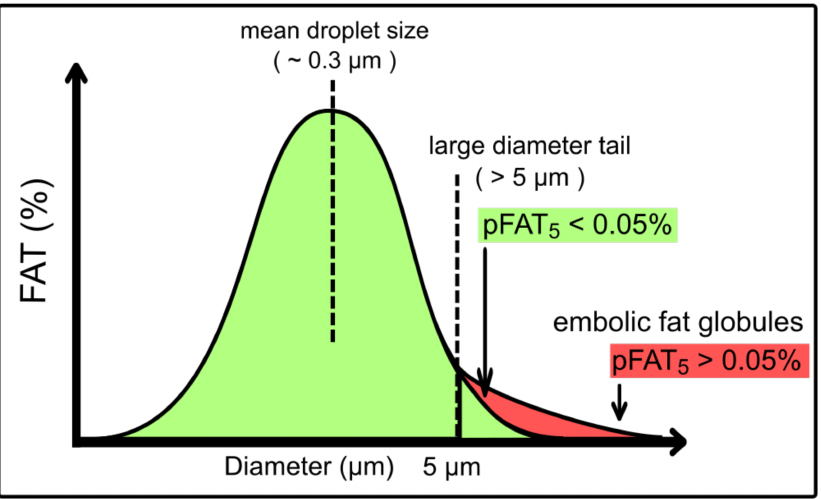
Figure 2. Normal globule distribution of a parenteral lipid emulsion with large diameter tailing. The shaded green area indicates the fat globule population with a lower proportion (pFAT5 < 0.05%) of large droplets (>5 µ m). The shaded red area indicates the globule population with an embolic large droplet (>5 µ m) amount (pFAT5 >